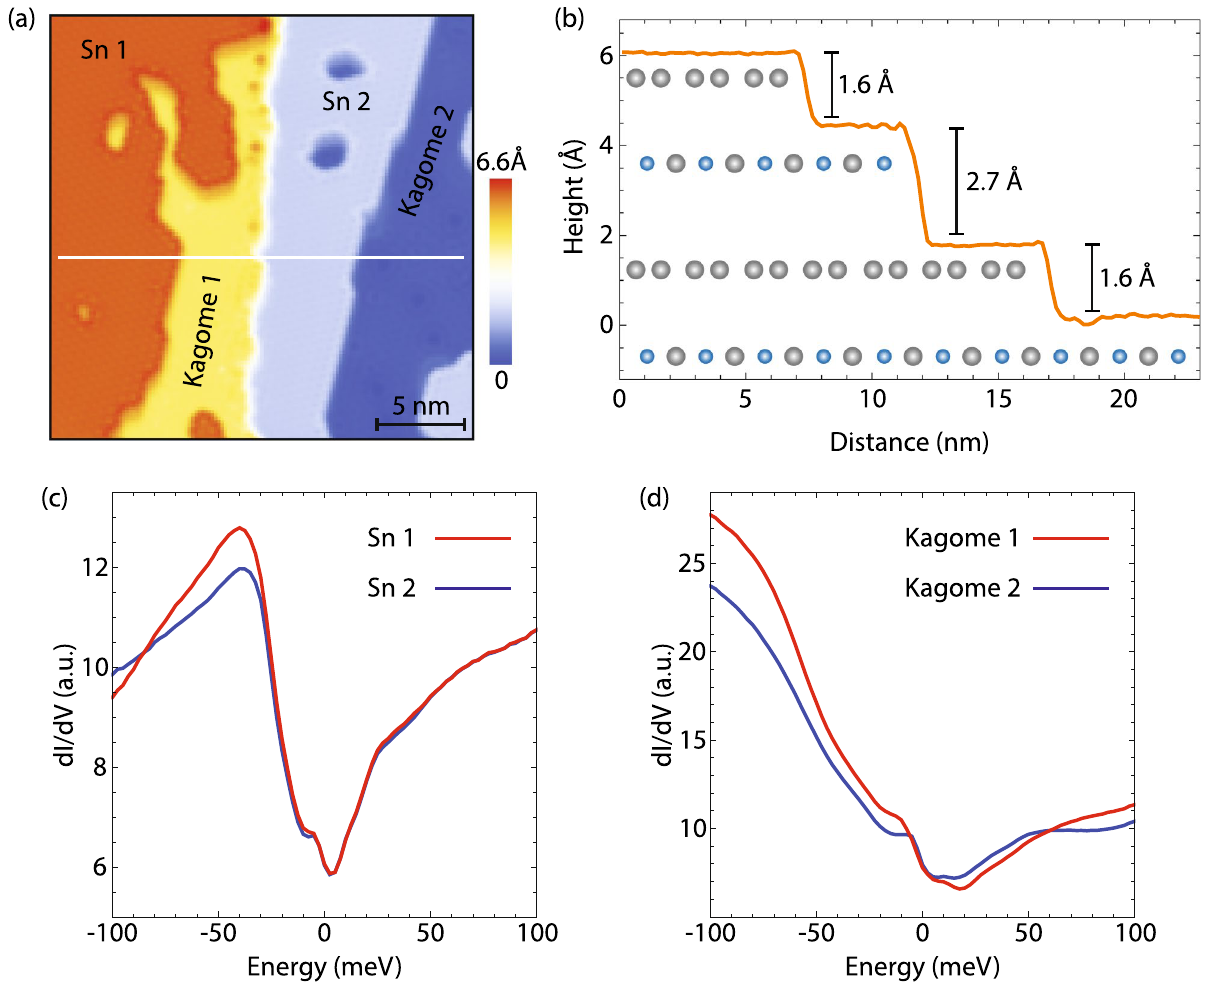
Figure 4. Spin-polarized imaging of different surface terminations. ( a ) STM topograph showing consecutive Sn–Fe 3 Sn–Sn–Fe 3 Sn terraces. ( b ) Topographic profile along the white line denoted in (a). ( c , d ) Average dI/dV spectra acquired on the inequivalent ( c ) Sn and ( d ) Fe 3 Sn terminations. STM setup conditions: ( a ) I set = 200 pA, V sample = − 45 mV; ( c , d ) I set = 600 pA, V sample = 100 mV, V exc = 2